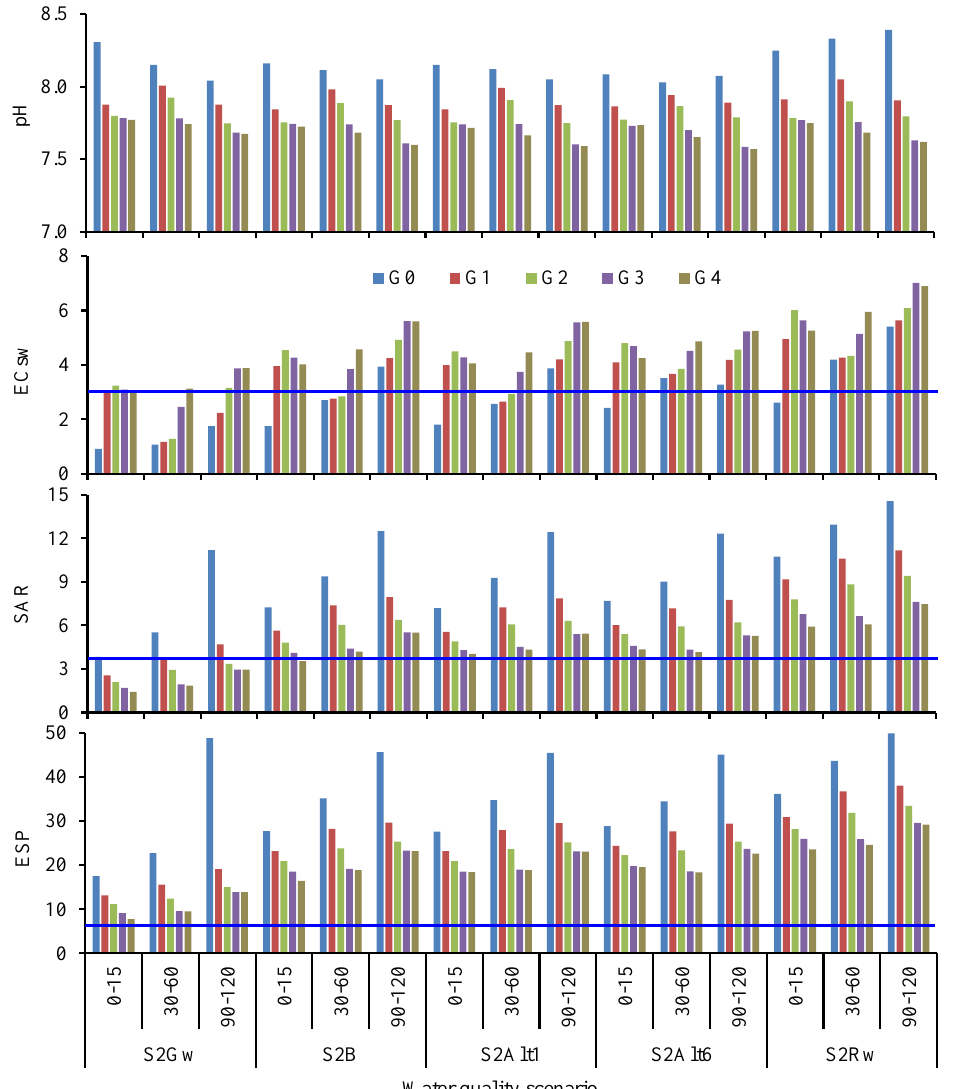
Figure 8. Average values of pH, EC sw , SAR, and ESP in hard red-brown soils (S2) for different water qualities (recycled water, RW; good water, GW; blending RW and GW in a 1:1 ratio, B; RW and GW used in monthly cycles, Alt1; R and GW used half-yearly cycles, Alt6) and annual gypsum additions of 0 (G0), 1.7 (G1), 4.3 (G2), 8.6 (G3), and 12.9 (G4) t/ha.